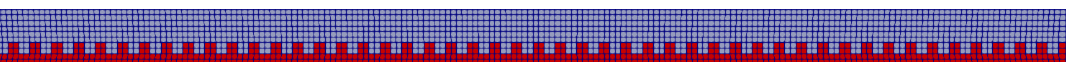
Figure 2. Numerical model that mimics the experimental desiccation test of soil. Note: the notches are in